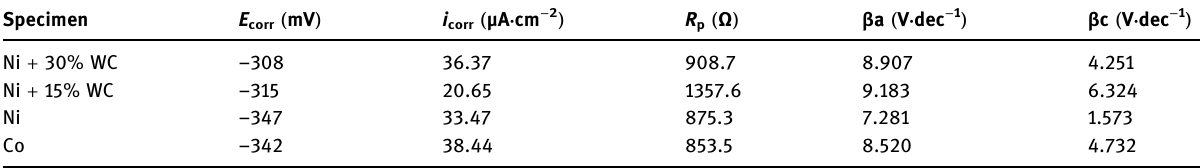
Table 5: Corrosion parameters fi tting results according to the potential dynamic polarization curves in 0.5 mol · L − 1 HCl solution for 120 h